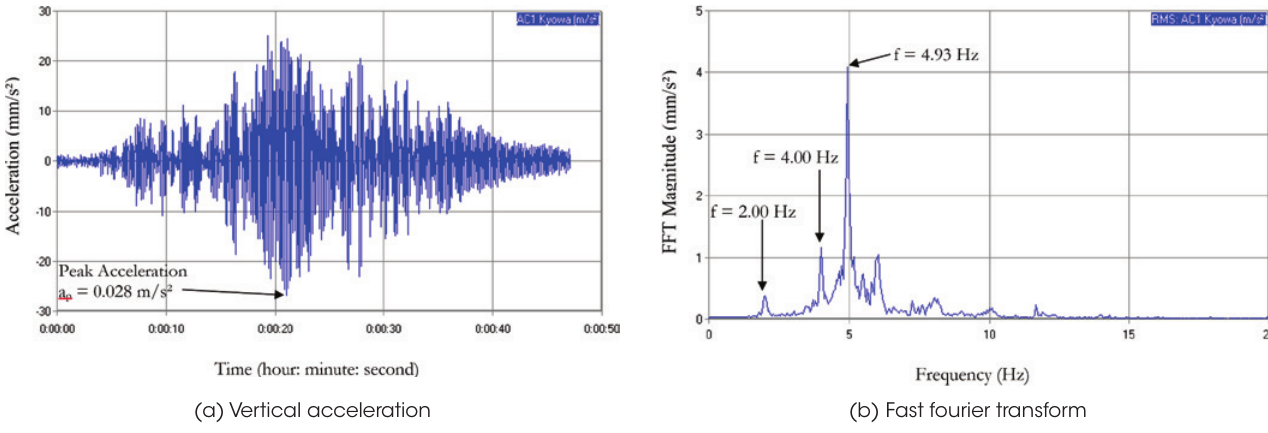
(a) Vertical acceleration Figure 19 Dynamic structural response of the footbridge due to normal walking of 8 people (f